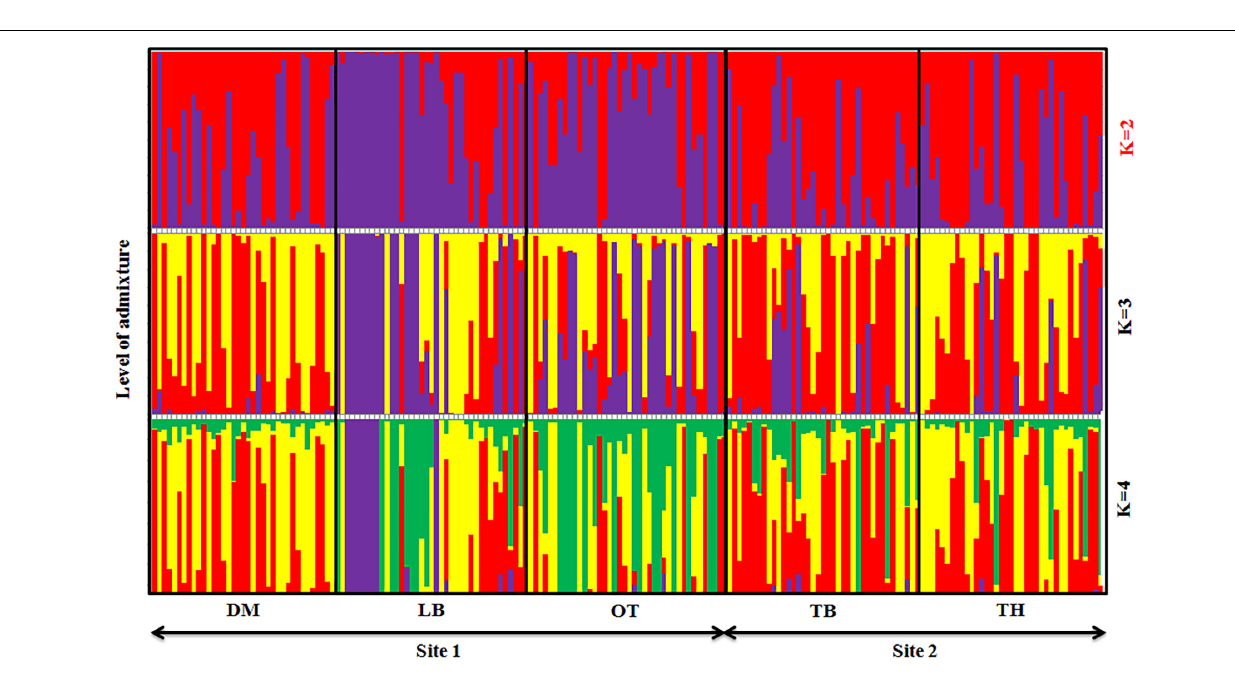
FIGURE 6 | Summary bar plot of estimates of Q (the estimated membership coefficient for each individual in each cluster). Each individual is represented by a single vertical line broken into K colored segments with lengths proportional to K inferred clusters (best K =